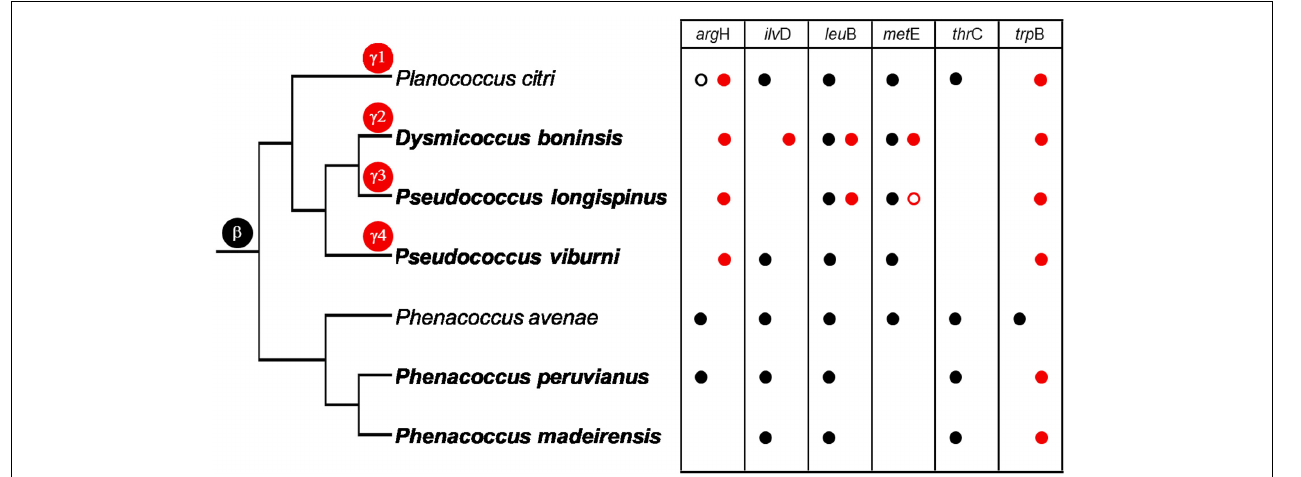
FIGURE 1 | Genetic screening of selected loci involved in essential amino acid biosynthesis. The taxonomic assignation of the amplified sequences is indicated by black (betaproteobacteria) and red (gammaproteobacteria) circles. Empty circles represent pseudogenes. The species analyzed in this work appear in bold. P. citri and P. avenae endosymbionts are shown for comparison. Cladogram topology represents